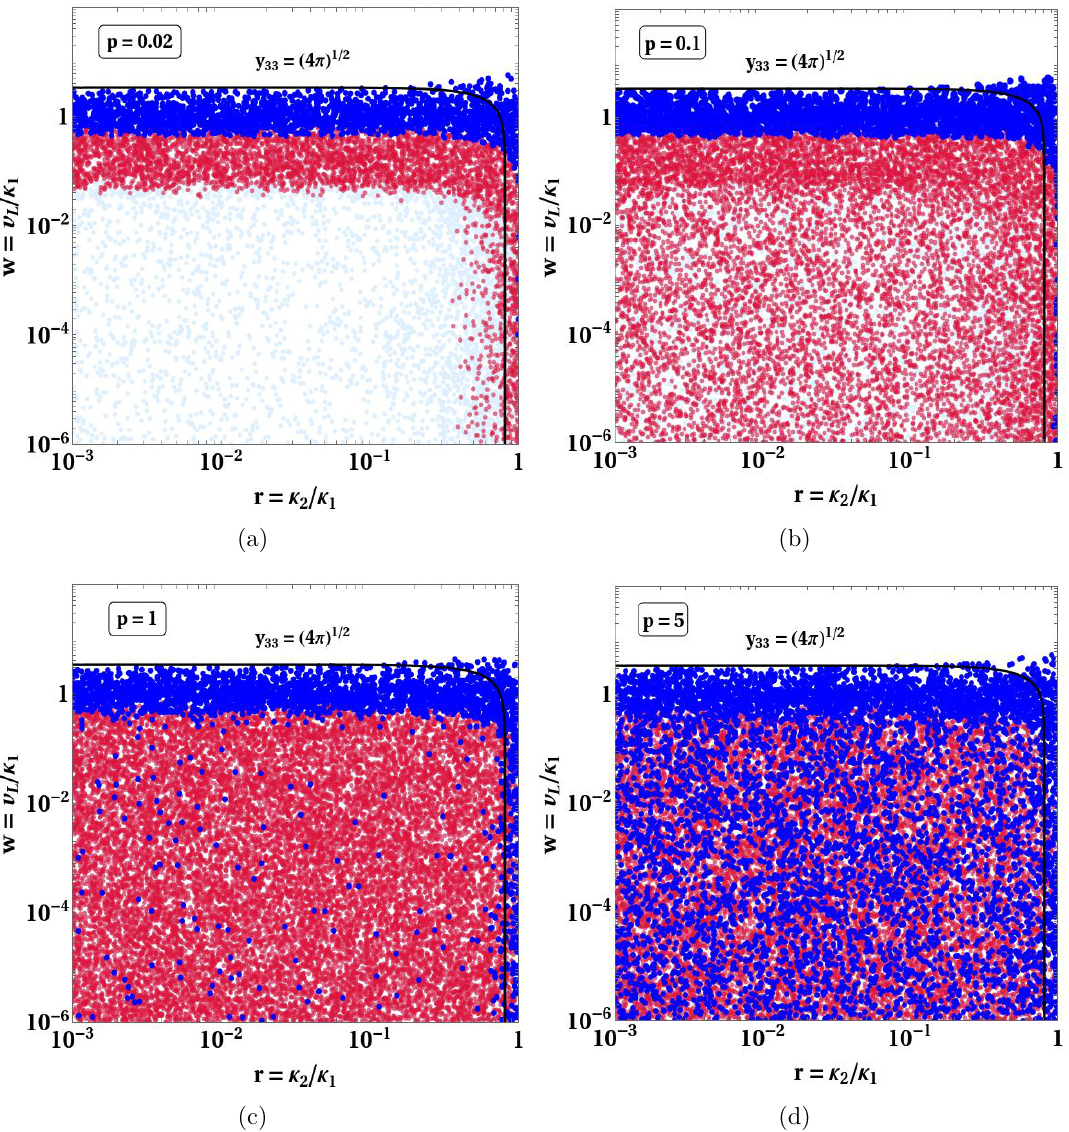
Figure 2. Allowed points on the r - w plane with random values of α 1 , 2 , 4 = α 0 ∈ [10 − 3 , 4 π ] , λ 1 , 3 , 4 = λ 0 ∈ [10 − 3 , 4 π ] , x = λ 2 /λ 0 ∈ [0 . 25 , 0 . 85] , ρ 1 ∈ [0 . 1 , 4 π ] for four different values of p . The values of q and v are held fixed at q = 1 and v = 20 TeV respectively. Light blue points satisfy R R m h , κ h , κ W , κ Z and κ t constraints and theoretical bounds. Red points satisfy κ b constraint also and dark blue points satisfy the additional constraint m 15 H 1 >